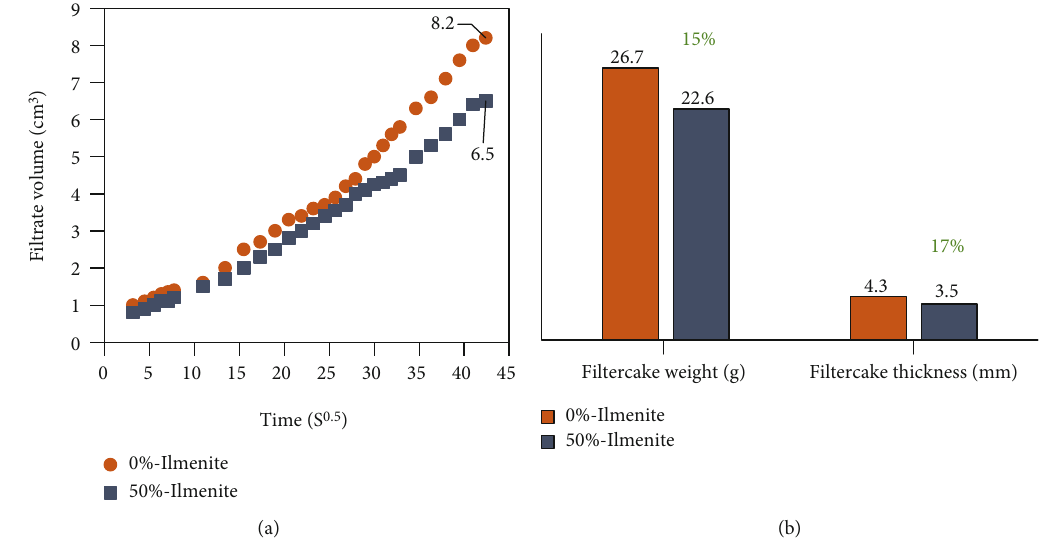
Figure 8: E ff ect of adding ilmenite on (a) fi ltration volume and (b) fi lter cake weight and